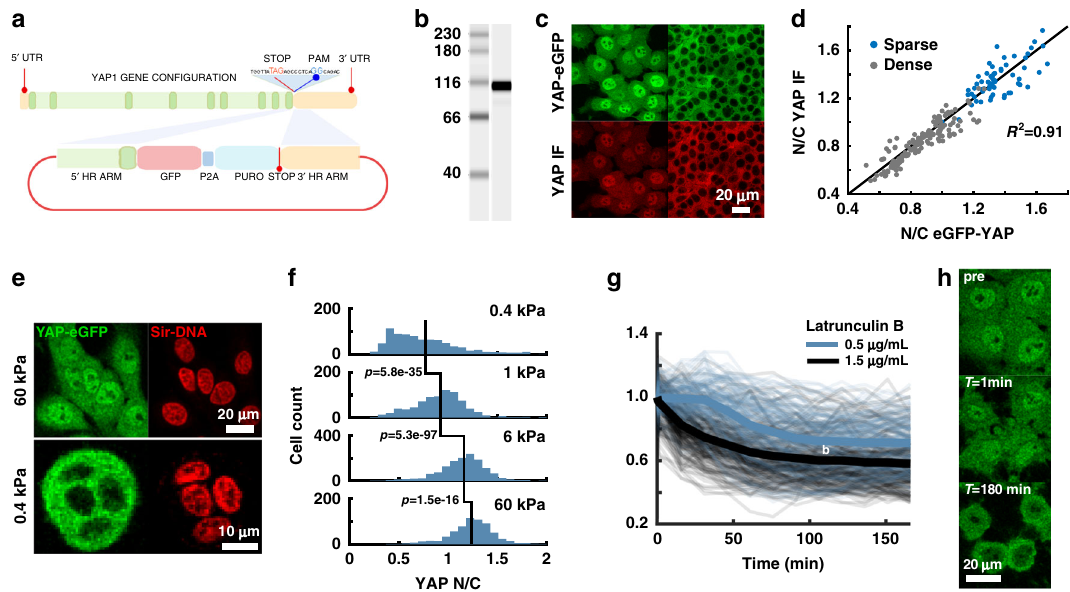
Fig. 1 Characterization of YAP and TEAD genome-knockin cell lines. a Cartoon of CRISPR-Cas9 based insertion of eGFP-P2A-puromycin cassette at 3 ′ end of the YAP gene. b western blot against eGFP from MCF10A YAP -GFP-KI whole cell lysate. Single predominant band at the predicted YAP-eGFP fusion size 96 kDa. Repeated twice with similar results. c Correlation of the YAP nuclear/cytoplasmic ratio ( N / C ) signal for YAP-eGFP and anti-YAP immuno fl uorescence in sparse and dense cultures. N sparse = 61 cells, N dense = 155 cells from one experiment. Repeated twice with similar results. d Representative Immuno fl uorescence images of data from c . e MCF10A YAP -GFP-KI cells plated on soft (0.4 kPa) and stiff (60 kPa) acrylamide showing altered cell morphology and YAP localization. Cells were counterstained with the live-cell nuclear stain, SiR-DNA ™ . f Quantitative comparison of YAP- eGFP N / C on fi bronectin coated acrylamide of varying stiffnesses. N 0.4 kPa = 834, N 1 kPa = 818, N 6 kPa = 1386, N 60 kPa = 647 cells. A one-sided Mann – Whitney U -test was used to test differences in YAP N / C . 0.4 kPa vs. 1 kPa: 5.8 × 10 − 35 , Ranksum = 570,253. 1 kPa vs. 6 kPa: p = 5.3 × 10 − 97 , Ranksum = 600,652. 6 kPa vs. 60 kPa: P = 1.452 × 10 − 16 , Ranksum = 1,308,747. Data compiled from two independent experiments for each condition. g Time-course of YAP N/C normalized to initial value following Latrunculin B treatment at 0.5 µ g/mL (140 cell traces) and 1.5 µ g/mL (256 cell traces). Individual cell traces in transparent lines with mean plotted as solid line. Data compiled from one independent experiment for each condition. h Fluorescent images of YAP-eGFP before and after Latrunculin B treatment for the indicated